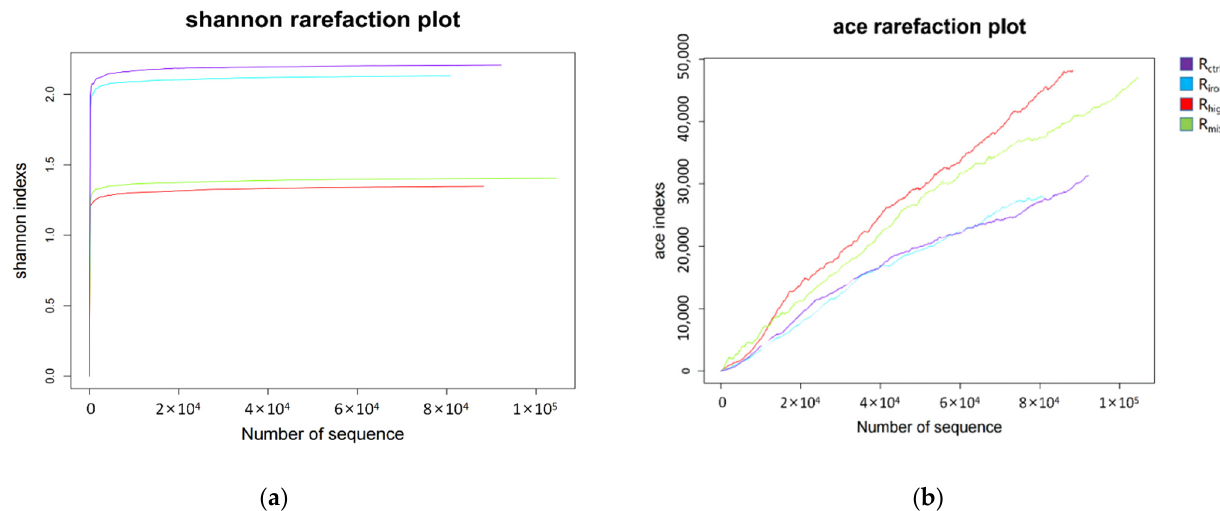
Figure 5. Alpha diversity based on the Shannon and Ace indexes at different experimental conditions. ( a ) Shannon rarefaction plot; ( b ) ace rarefaction plot.